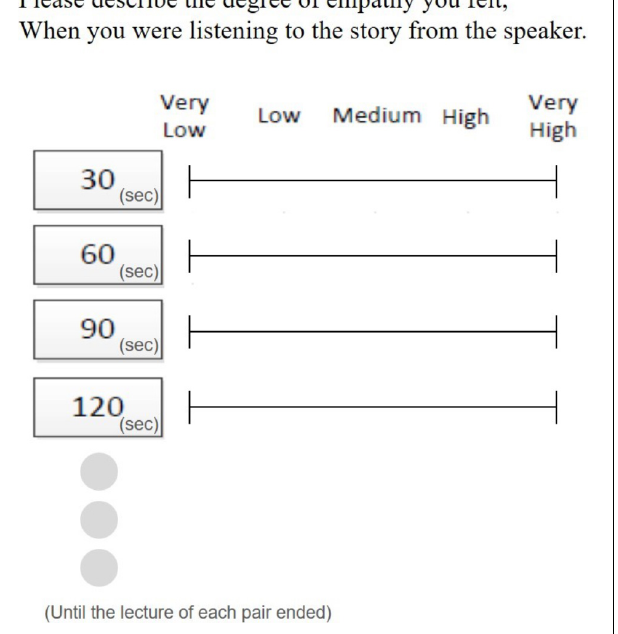
FIGURE 1 | Questionnaire about the listener’s degree of empathy. The listener stopped the video of the lecture every 30 s and filled in their degree of empathy on the